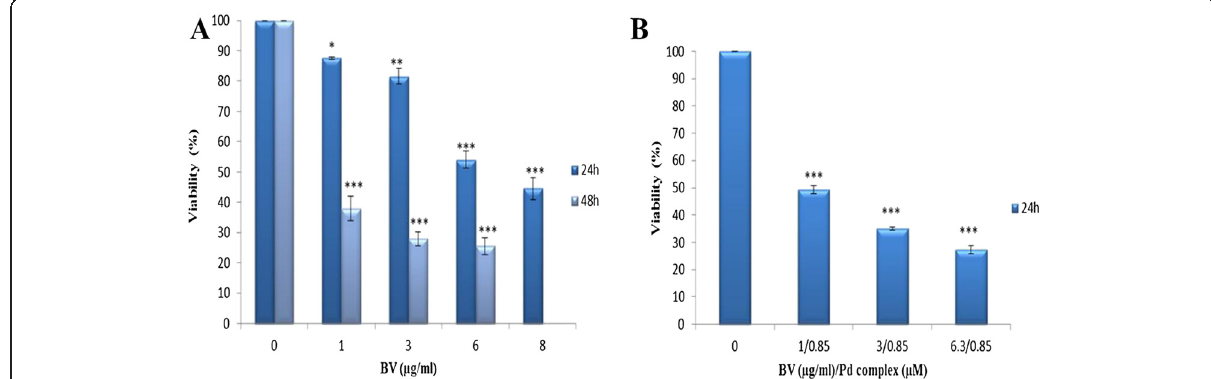
Figure 1 Growth inhibition and cell death were determined via MTT assay. (A) Dose- and time-dependent effect of BV and (B) dose effect of BV/Pd (II) complex on viability of MOLT-4 cells. Results are presented as mean ± S.E.M. n = 3; ** p > 0.01 and *** p > 0.001 significantly different from the